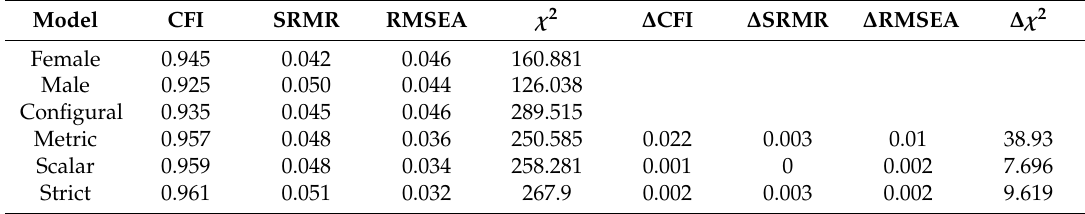
Table 3. Goodness-of-fit indices of models testing for cross-gender invariance.